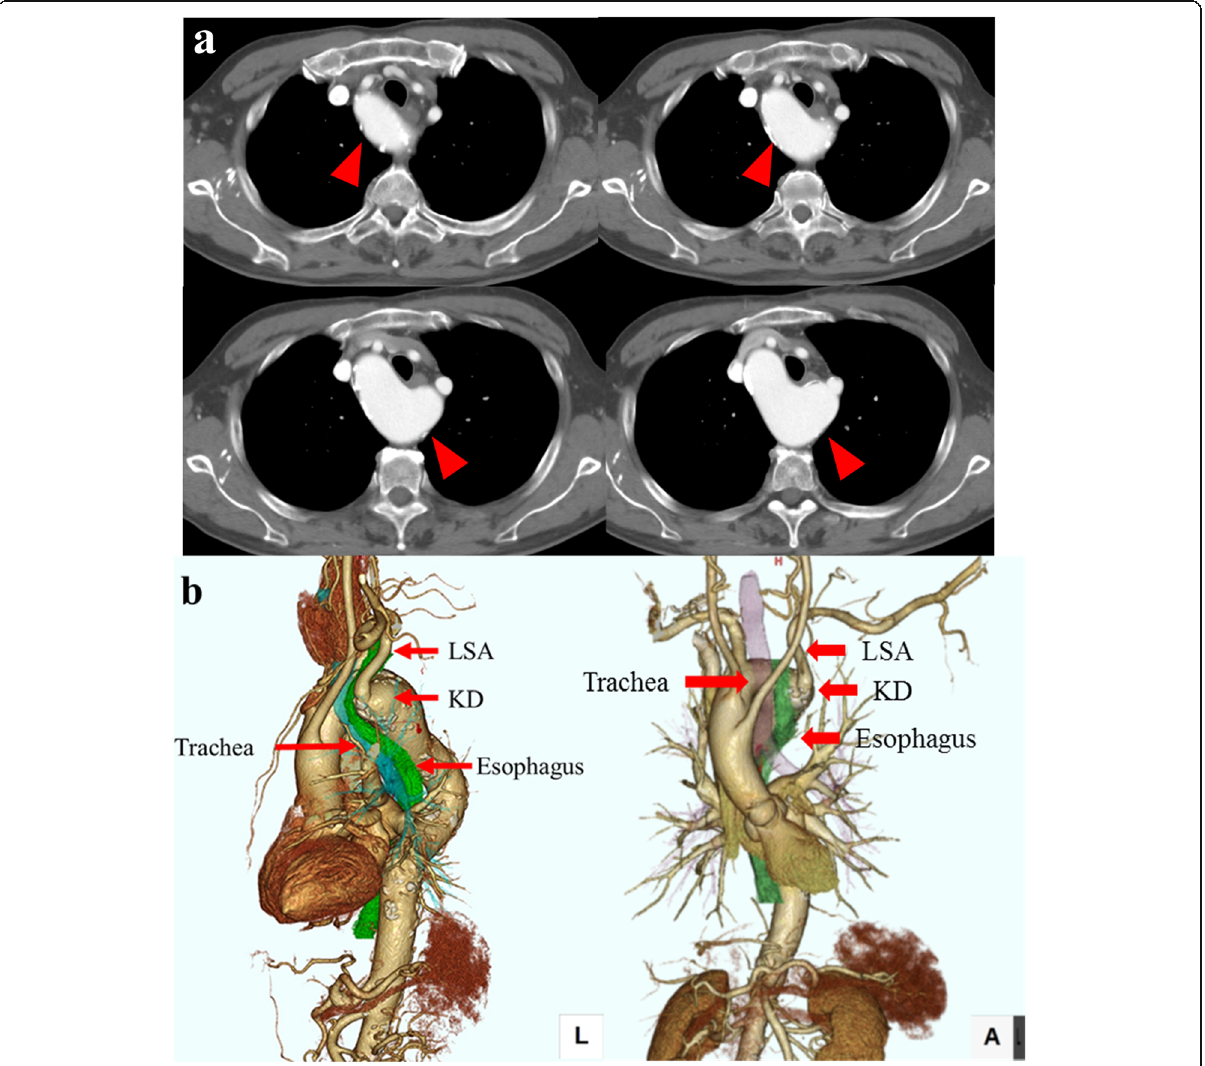
Fig. 2 Preoperative CT findings. a Transverse image: the right aortic arch (arrow) surrounding the trachea and esophagus from the dorsal side. b 3D-CT findings: Edwards classification type IIIB1, with Kommerell ’ s diverticulum at the origin of the descending aorta, from which the left subclavian artery can be seen to be bifurcating ectopically. LSA: left subclavian artery, KD: Kommerell ’ s